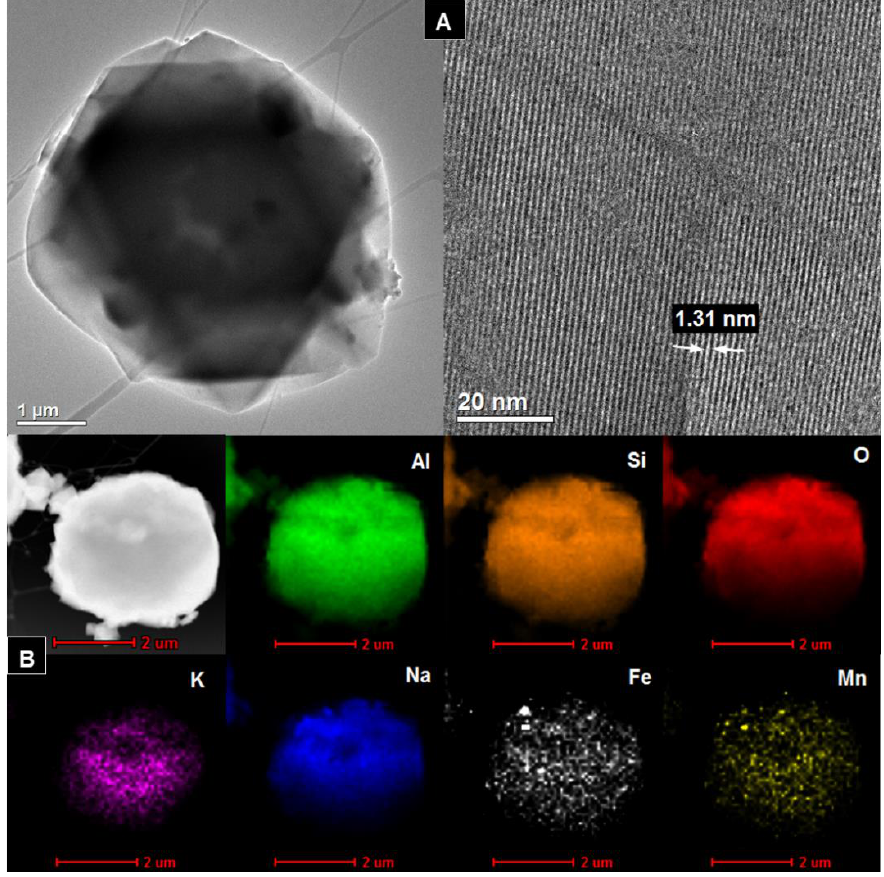
Figure 4. ( A ) HR/TEM images and ( B ) STEM-EDS analysis of Na-X-LS sample.